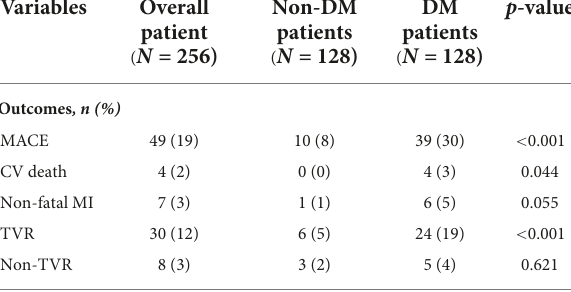
TABLE 3 Clinical outcomes of enrolled patients stratified by DM.